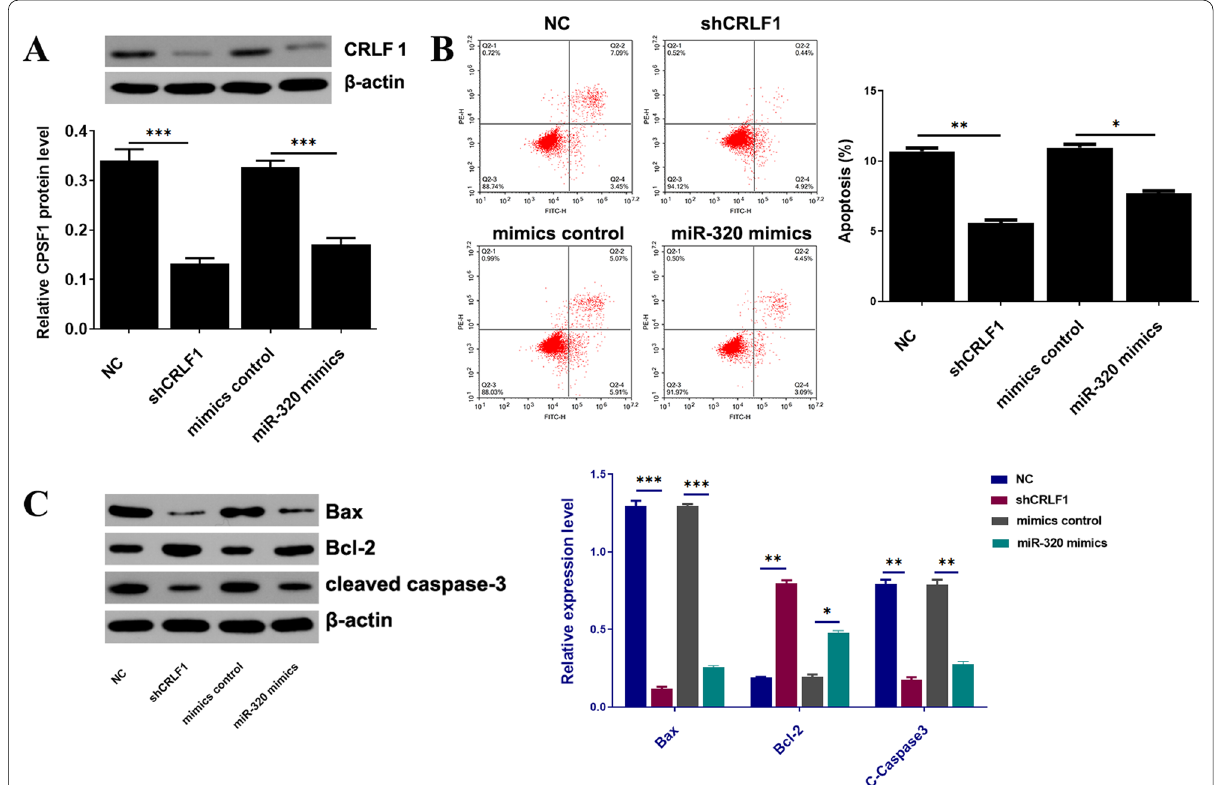
Fig. 6 knockdown of CRLF1 or over-expression of miR-320 can inhibit the apoptosis of primary chondrocytes isolated from the articular cartilage tissues of OA mice. A The CRLF1 expression in chondrocytes transfected with shCRLF1, miR-320 mimics and their controls. B Apoptosis was examined by flow cytometric analysis using Annexin V/PI assay. C The expression of apoptosis-related proteins in different transfected